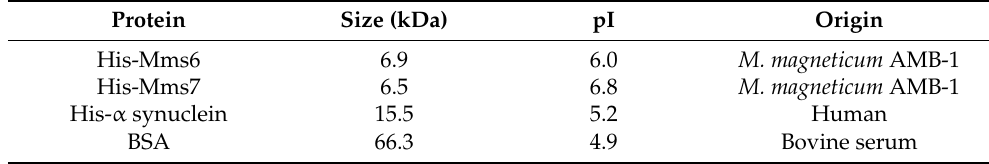
Figure 1. Characteristic amino acid sequences in the Mms proteins. The structure prediction of Mms6 ( A ) and Mms7 (B ) by RaptorX software. ( C ) The sequence alignment of the N-terminal hydrophobic region. ( D ) The sequence alignment of the C-terminal hydrophilic region; acidic amino acids are highlighted in yellow. Table 1. List of the proteins used for the adsorption assay.